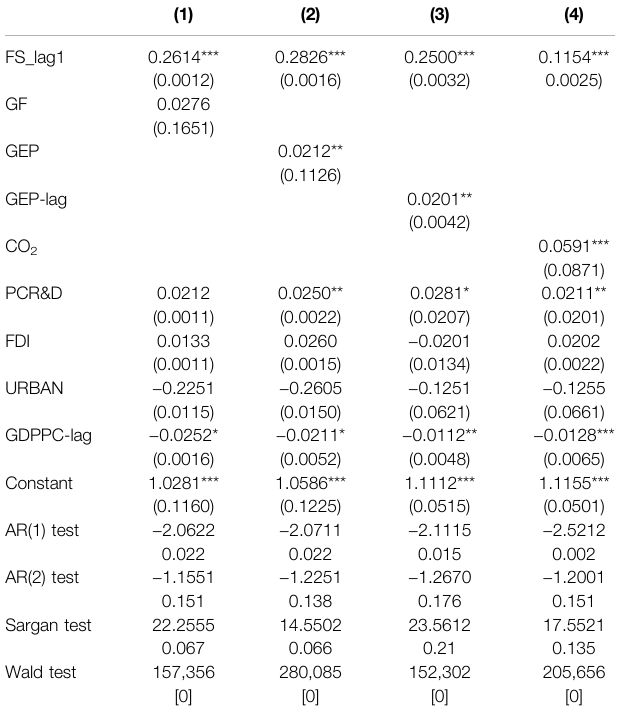
TABLE 8 | Ranking based on ef fi ciency of CO 2 emission. Country